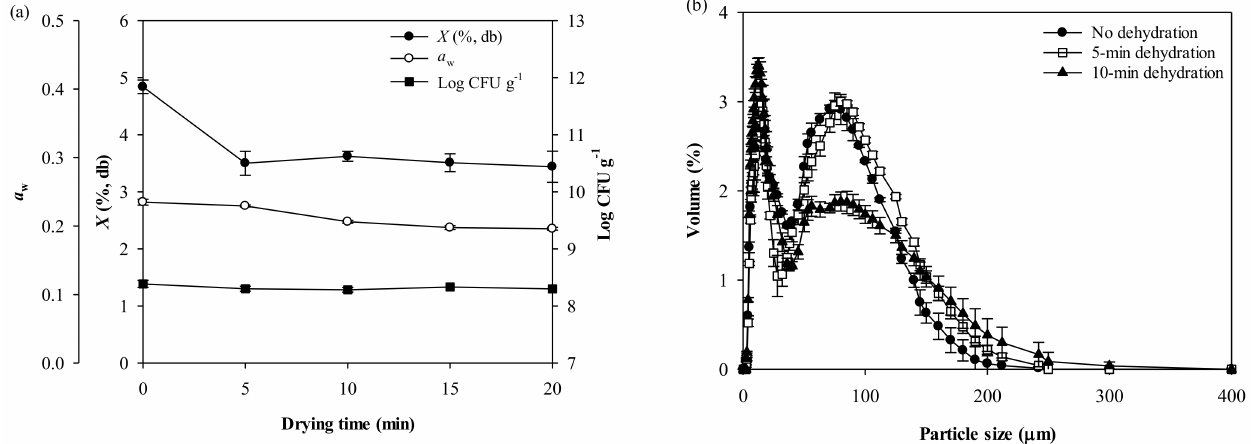
Figure 4. ( a ) Changes in the viable cells, moisture content ( X ), and water activity ( a w ) of moisture-activated LRP-SMP mixture (50:50) during 20-min dehydration at 50 ◦ C, and ( b ) the particle size distribution of the mixture treated with 5- or 10-min dehydration or without dehydration.